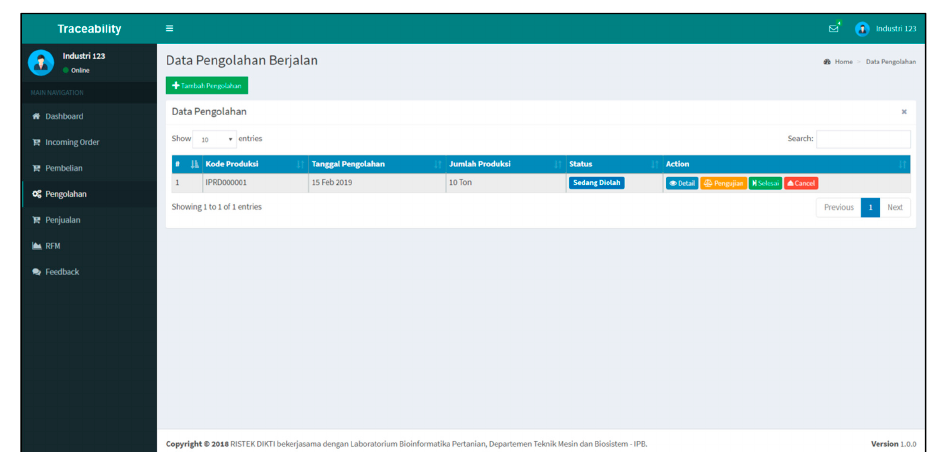
Figure A1. User login .